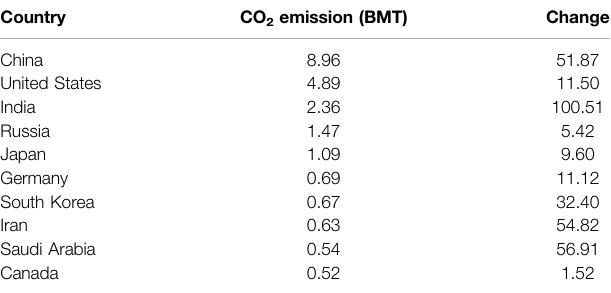
TABLE 1 | Top 10 CO 2 emitter countries in 2018.